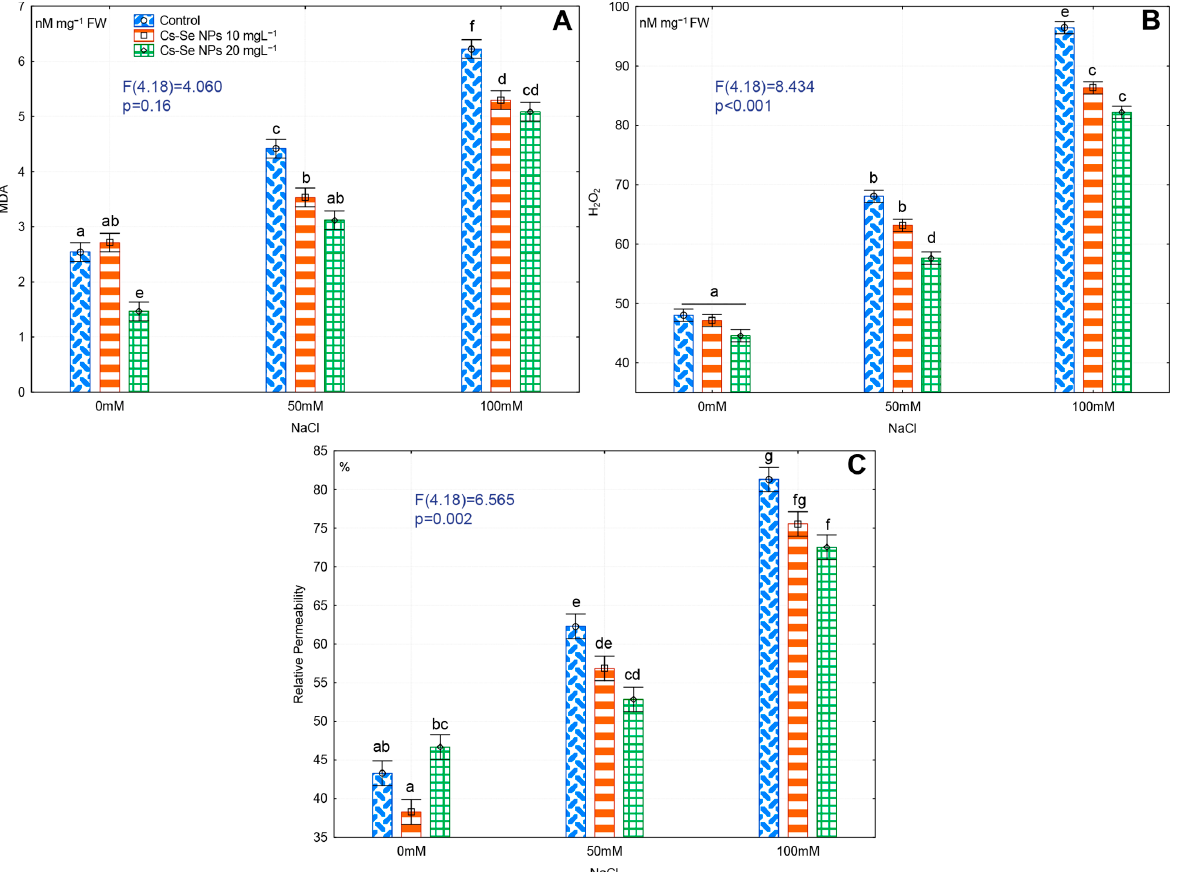
Figure 3. Effect of increasing concentration of Cs–Se NPs on MDA ( A ), H 2 O 2 ( B ), and relative permeability (%) ( C ) of bitter melon ( Momordica charantia ) leaves under salinity stress. The SDs denoted by lower-case letters in the same treatment indicate significant differences at p < 0.05 by Tukey’s post hoc test.